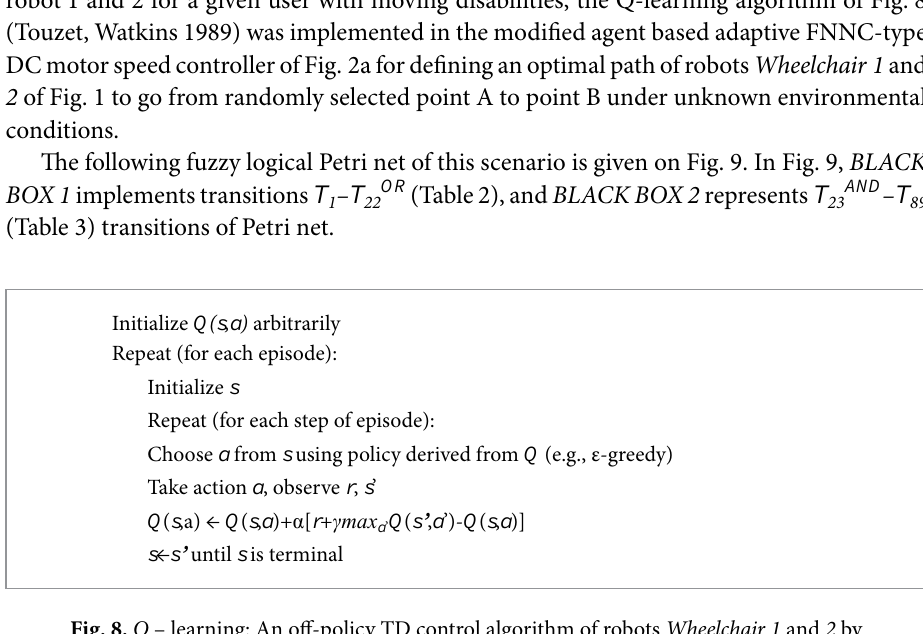
Fig. 8. Q – learning: An off-policy TD control algorithm of robots Wheelchair 1 and 2 by (Touzet, Watkins